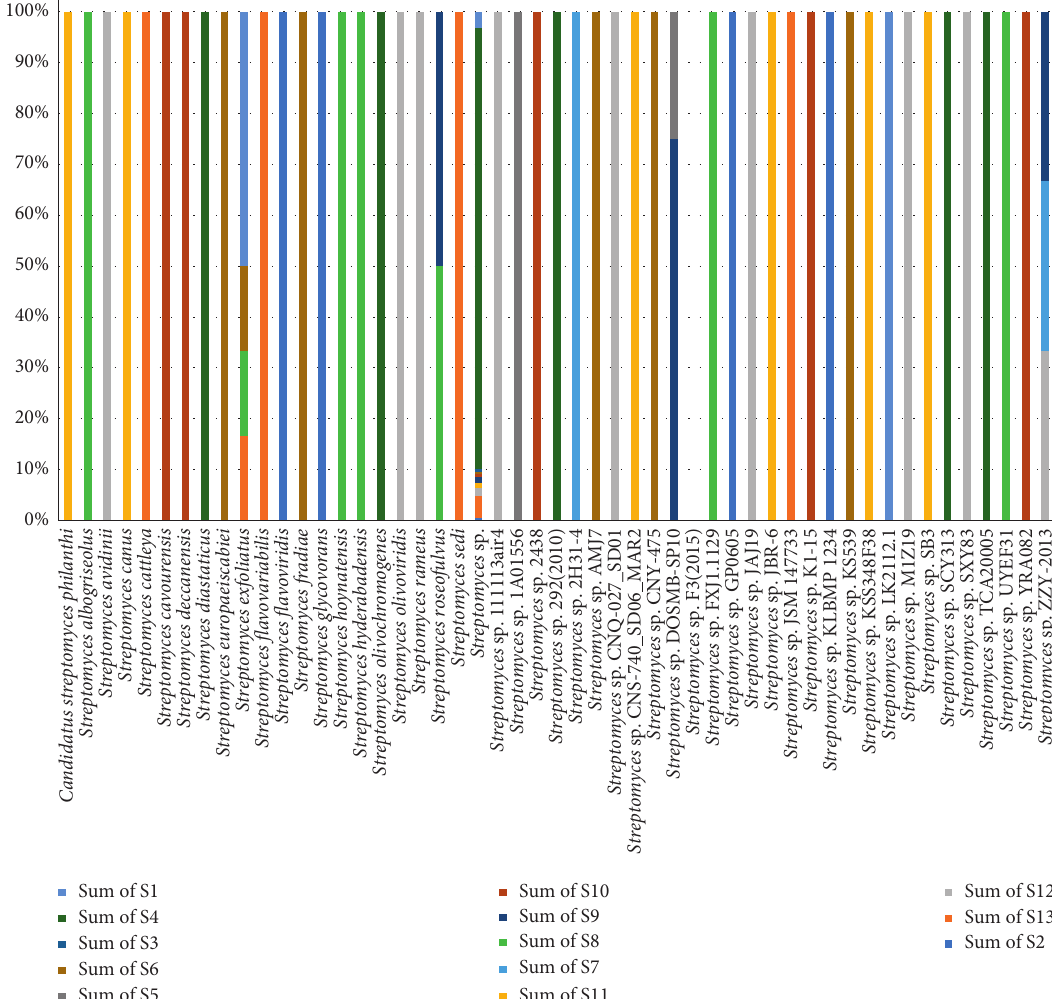
Figure 15: Relative abundance of Streptomyces sequence reads across the Pierce College Farm.